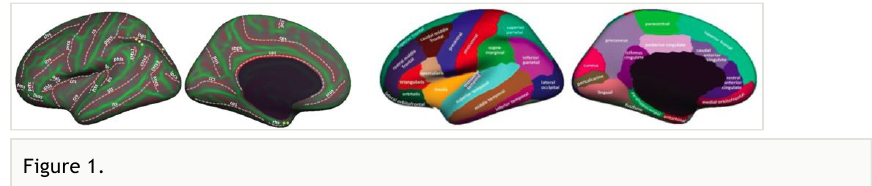
Brain labeling protocol (left, on an in fl ated cortex) and cortical labels (right) used by Mindboggle for extracting regions analyzed by our concurrence topology software.